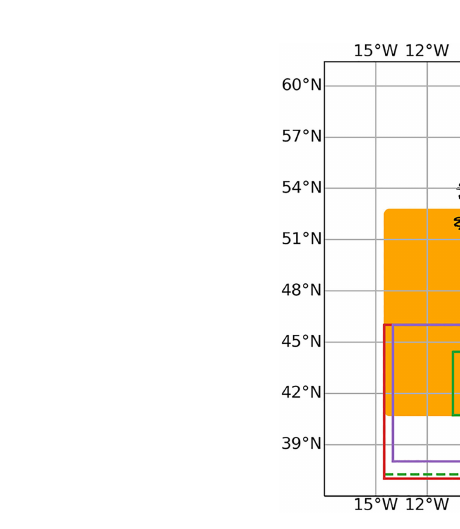
FIGURE 1 | The model domains of the models in the study PML (blue), IFREMER (orange), MeteoGalicia (purple), IEO BIO (red) and IEO RAIA (green) which has a parent grid (dashed line) and nested high resolution grid (solid